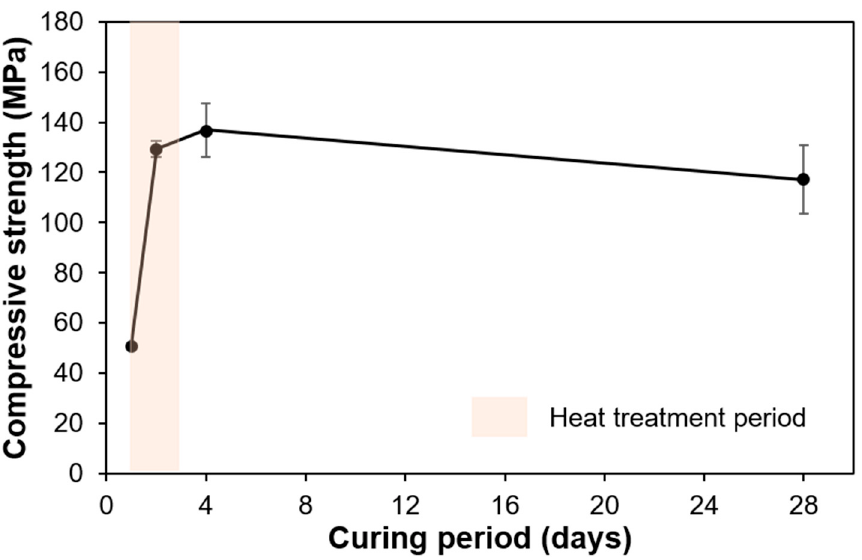
Figure 3. Compressive strength of the specimens .